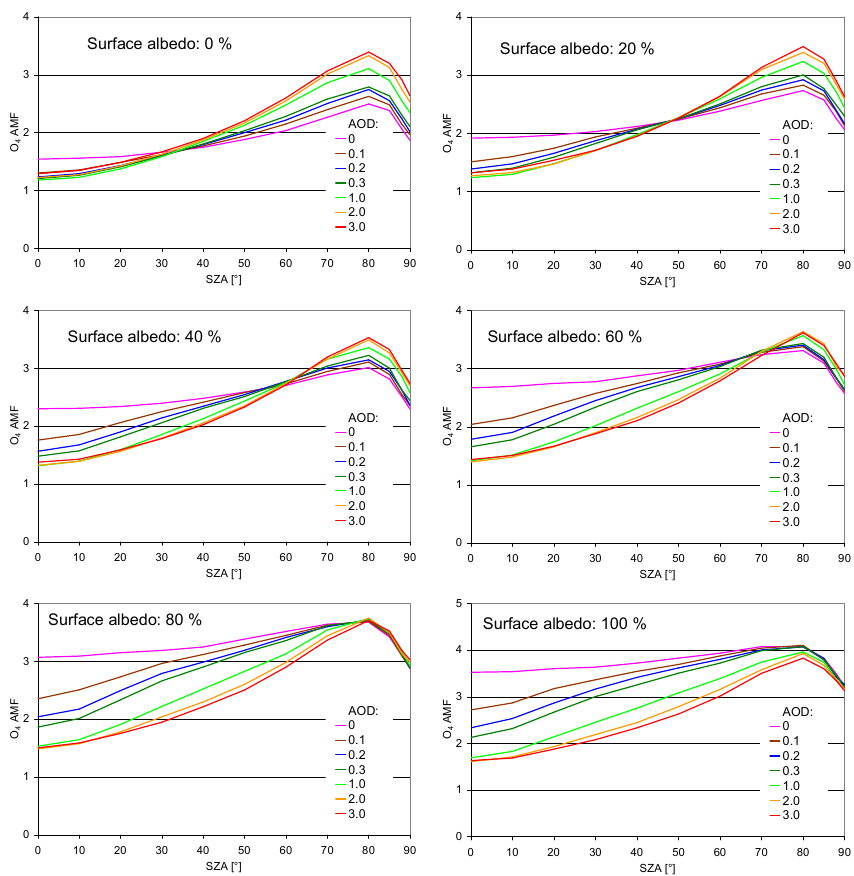
Figure A3. Simulated O 4 AMF for zenith direction for clear-sky conditions and different surface albedos. The different colours indicate results for different